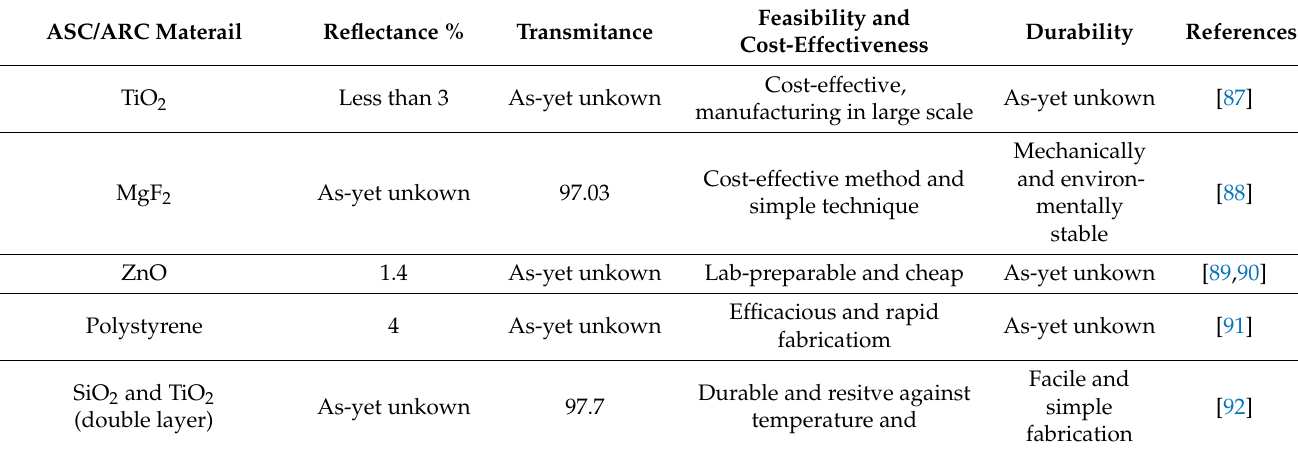
Table 1. Comparison of various ASC/ARC